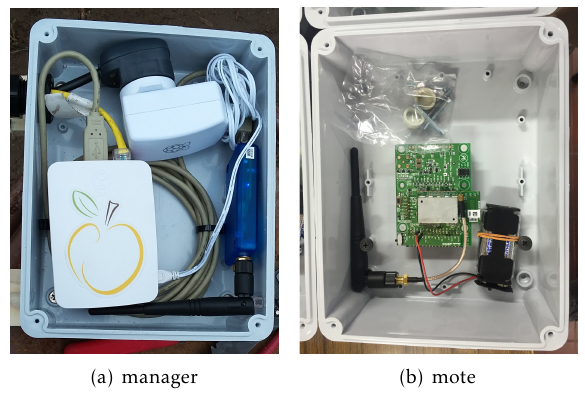
Figure 4. The boards deployed.